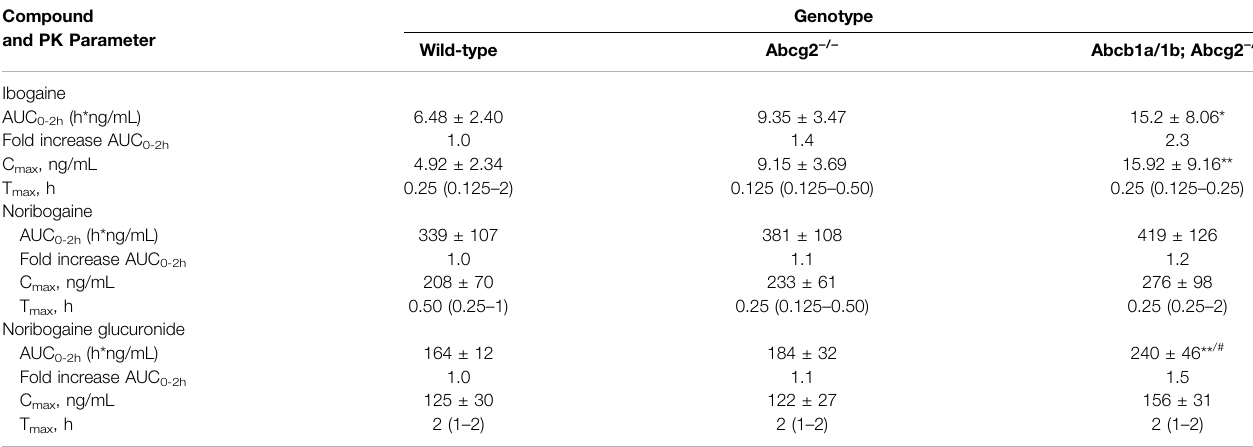
TABLE1| Plasmapharmacokinetic(PK)parametersofibogaine,noribogaine,andnoribogaineglucuronide2 hafteroraladministrationof10 mg/kgibogainetofemalewild- type, Abcg2 − / − , and Abcb1a/1b;Abcg2 − / − mice a . Compound and PK Parameter